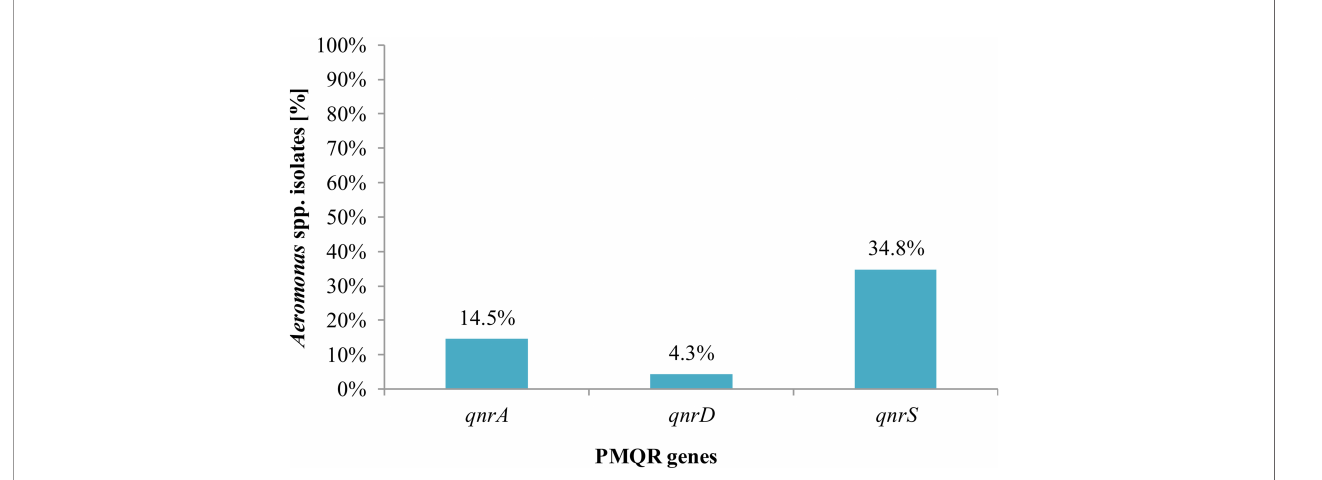
FIGURE 4 | Presence of plasmid-mediated quinolone resistance genes in Aeromonas spp. isolates from freshwater